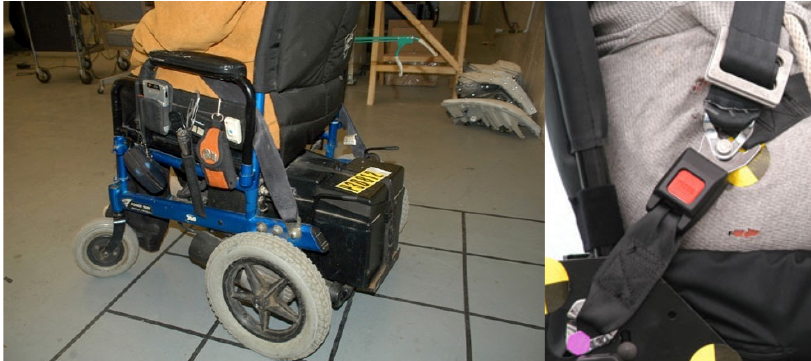
Figure 8. Crash ‐ tested wheelchair restraints. Figure 8. Crash-tested wheelchair